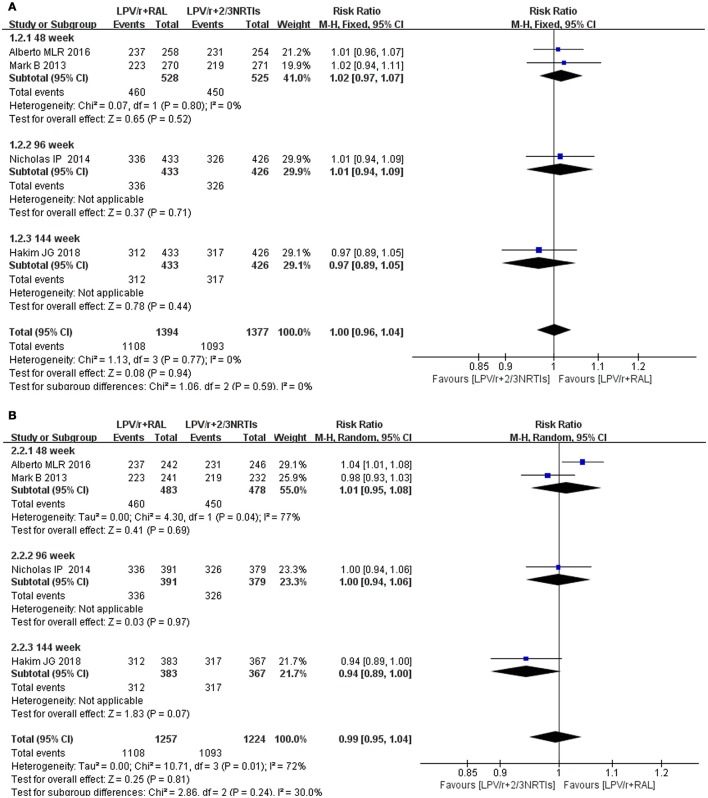
Forest plot of difference between 2-3 NRTI plus LPV/r and RAL plus LPV/r in virologic suppression. Each risk ratio represents the effect of the second-line treatment in people with HIV with previous ART failure. (A) Intention-to-treat analysis of HIV RNA <400 copies/mL (B) Pre-protocal analysis of HIV RNA <400 copies/mL. NRTI, nucleoside/nucleotide reverse transcriptase inhibitor; RAL, Raltegravir; LPV/r, Ritonavir-boosted lopinavir.